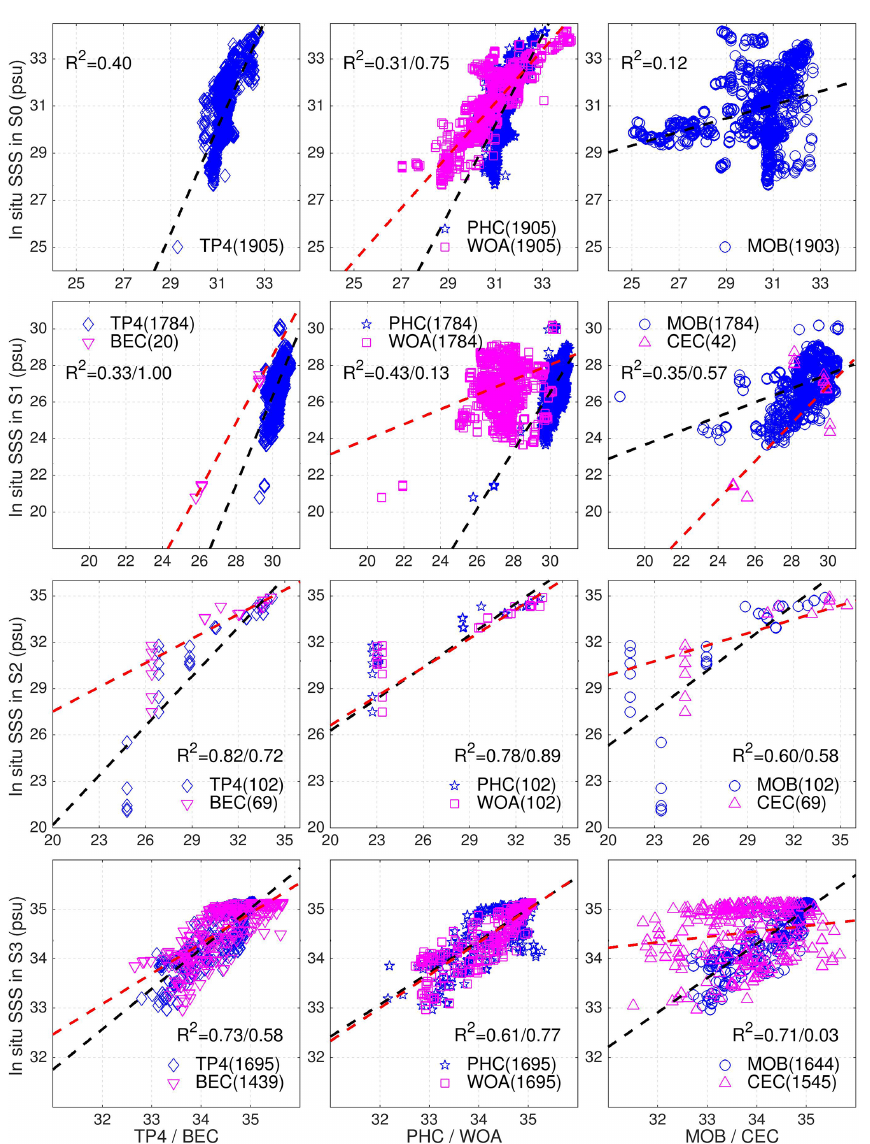
Figure 7. Scatterplots of SSS compared to the CORA5.1 in situ observations with respect to the S0–S3 regions in the Arctic. The diamonds, inverted triangles, stars, squares, circles, and triangles represent the SSS from TP4, BEC, PHC, WOA, MOB, and CEC, respectively. The black (red) lines are the linear regressions of the blue (purple) dots in each panel, and the coefficient R 2 between the evaluated product and the in situ SSS is indicated in the panels together with the number of observations in